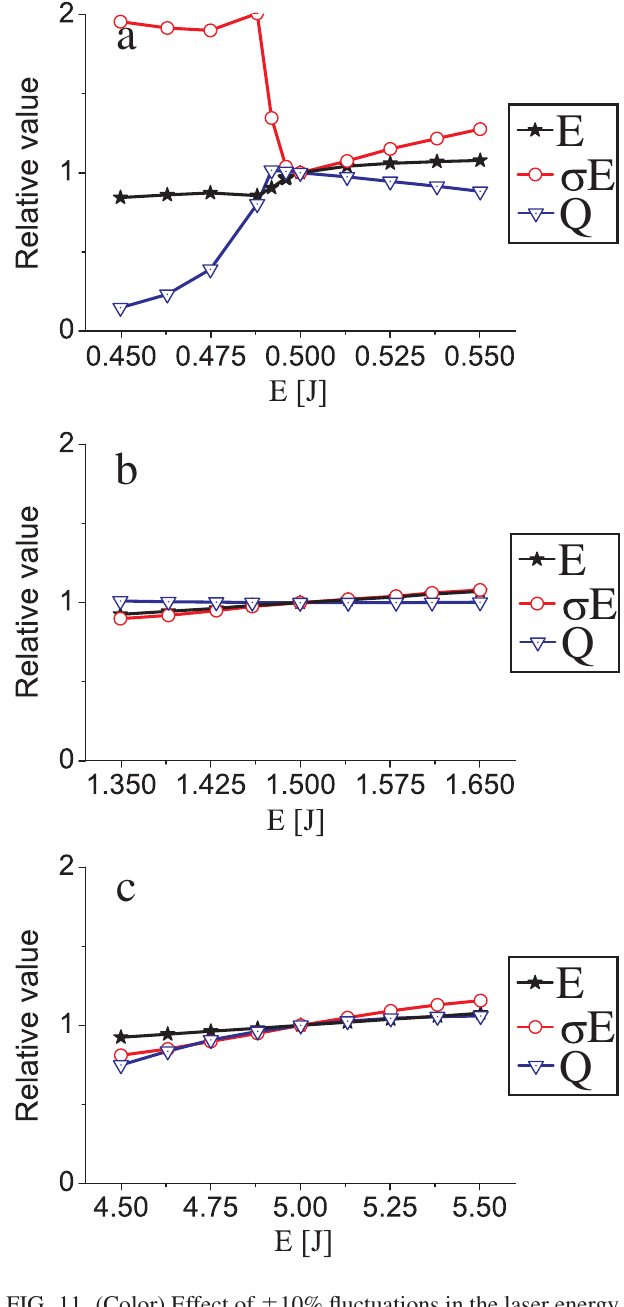
FIG. 11. (Color) Effect of (cid:1) 10% fluctuations in the laser energy on the final beam parameters [energy ( E ), energy spread ( (cid:5)E ), and trapped fraction ( Q )] for the different injection regimes: a 0 ¼ 0 : 32 (a), a 0 ¼ 0 : 56 (b), and a 0 ¼ 1 : 02 (c) with injection 300 fs in front of the laser